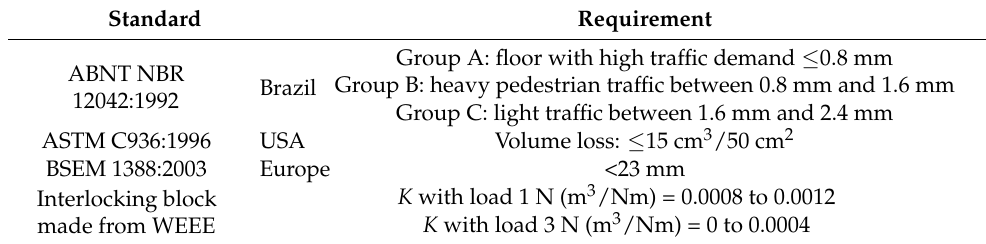
Table 6. Comparative table of resistance to